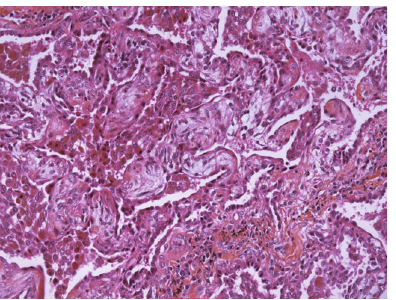
Figure 4: Bedside open lung biopsy performed on day 9 (HES × 200): lesions of bronchiolitis obliterans with organizing fibroblastic polyps in